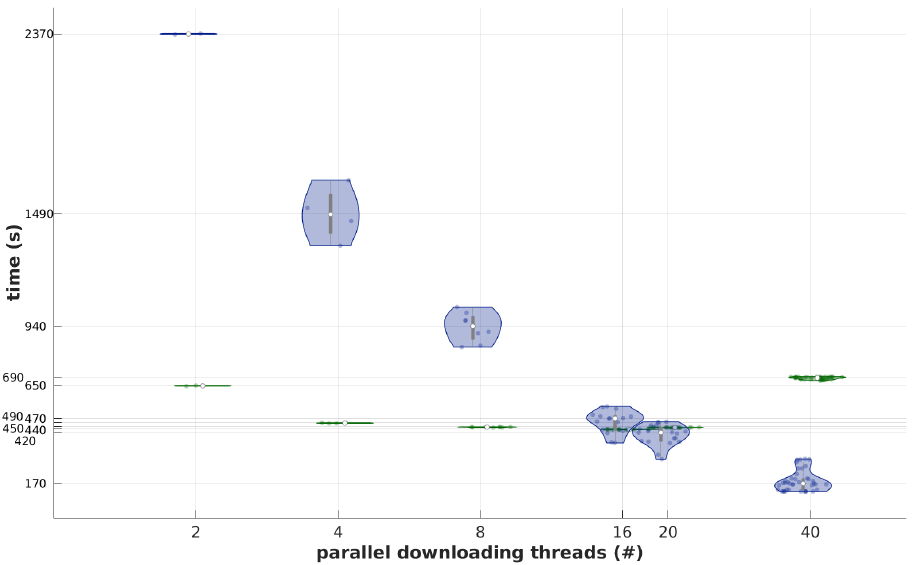
Figure 10. Image retrieval test set. On the horizontal axis, a number of parallel workers are depicted (each worker running in a separate thread). On the vertical axis, the time of every single worker in a batch, as well as the median time for each run, is presented. Green and blue boxes show times when retrieving from the Dcm4chee server or the cluster of central PACS nodes, respectively. In each run, the same amount (80) of studies were retrieved (ca. 16 GB). Most of the Dcm4chee-related operations finished in a similar time (hence the boxes are flattened), while the cluster-related operations were time-varying with average decreasing with the growing number of workers (throughput